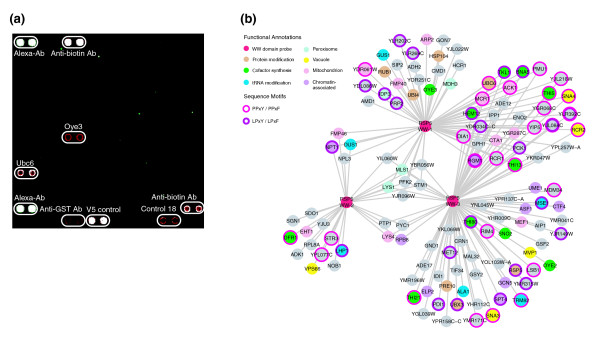
Protein microarray data and the Rsp5 network. (a) A microarray was probed with the first WW domain from Rsp5 and interactions were visualized via application of dye-labeled streptavidin and fluorescent scanning. Following data processing, two proteins (Ubc6 and Oye3) had signals above background. Control proteins (dye-labeled and biotinylated proteins) are indicated. (b) Interactions involving the WW domains from Rsp5. A total of 124 proteins were identified using the WW domains from Rsp5. Functional annotations are superimposed on the network using filled circles and outlines.